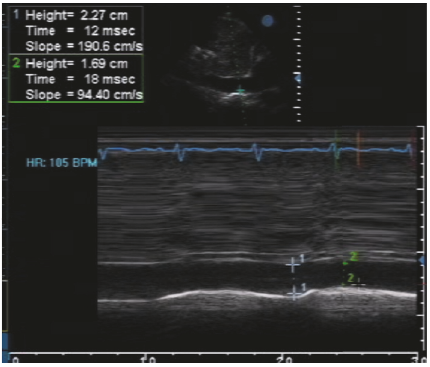
Figure 6: The IVC was dilated (23 mm), with minimal decrease in diameter on inspiration (only 26%), indicative of IVC plethora.